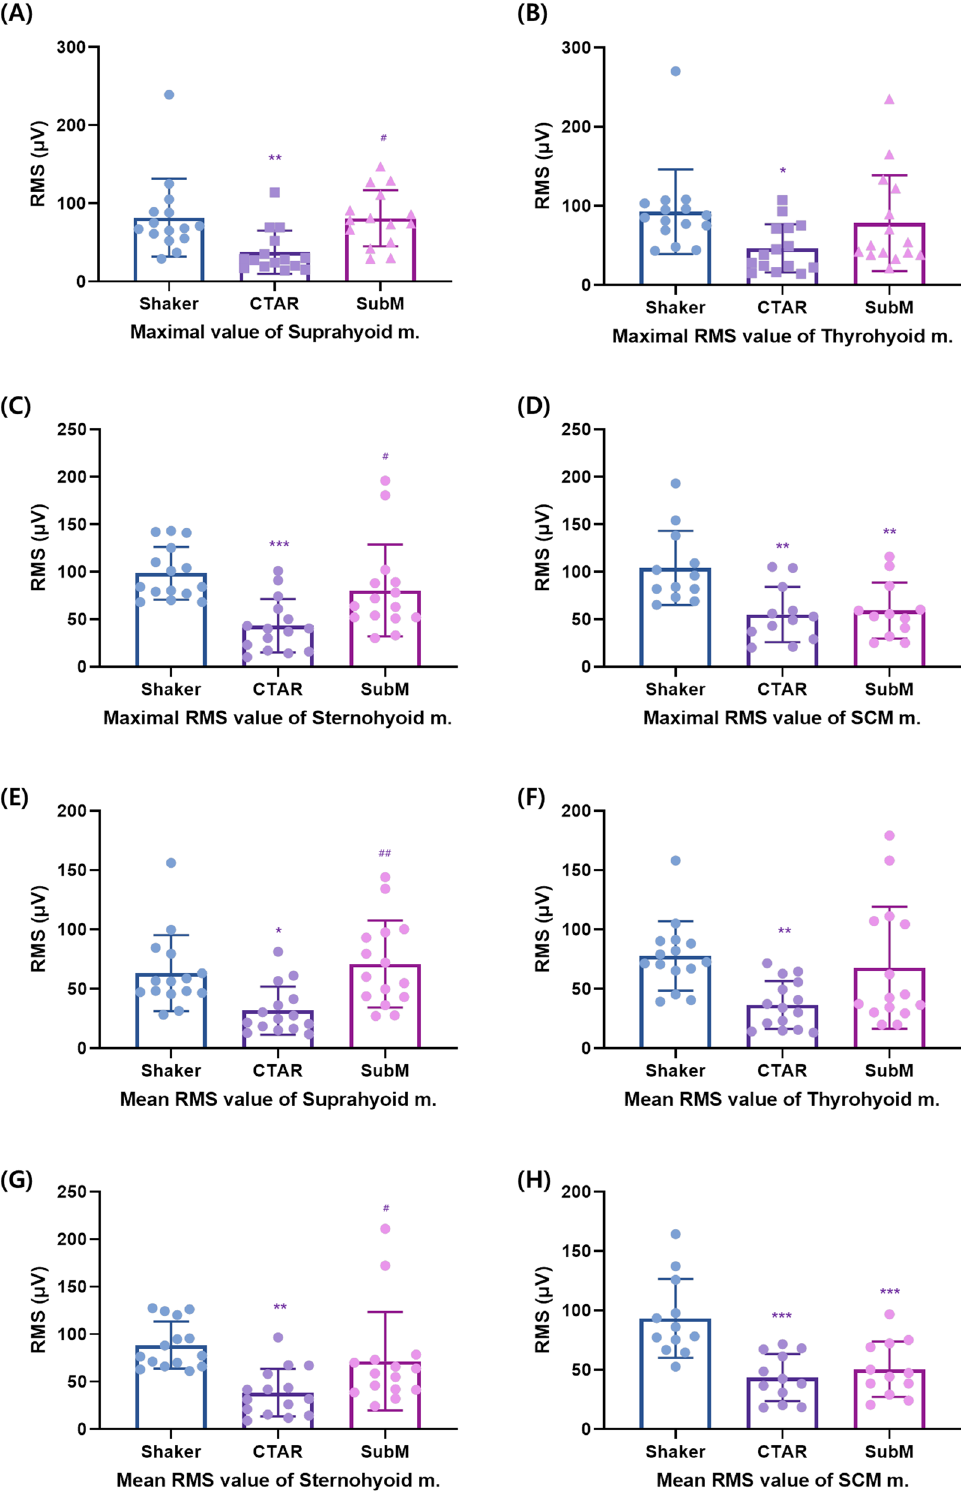
Figure 3. Maximal ( A – D ) and mean ( E – H ) RMS values of the suprahyoid, thyrohyoid, sternohyoid, and SCM muscles in patients with dysphagia. Graphs were drawn using GraphPad Prism software 8.0. RMS, root mean square; SCM, sternocleidomastoid. vs. Shaker; * p < 0.05, ** p < 0.01, *** p < 0.001, vs. CTAR; # p < 0.05, ## p < 0.01, ### p <